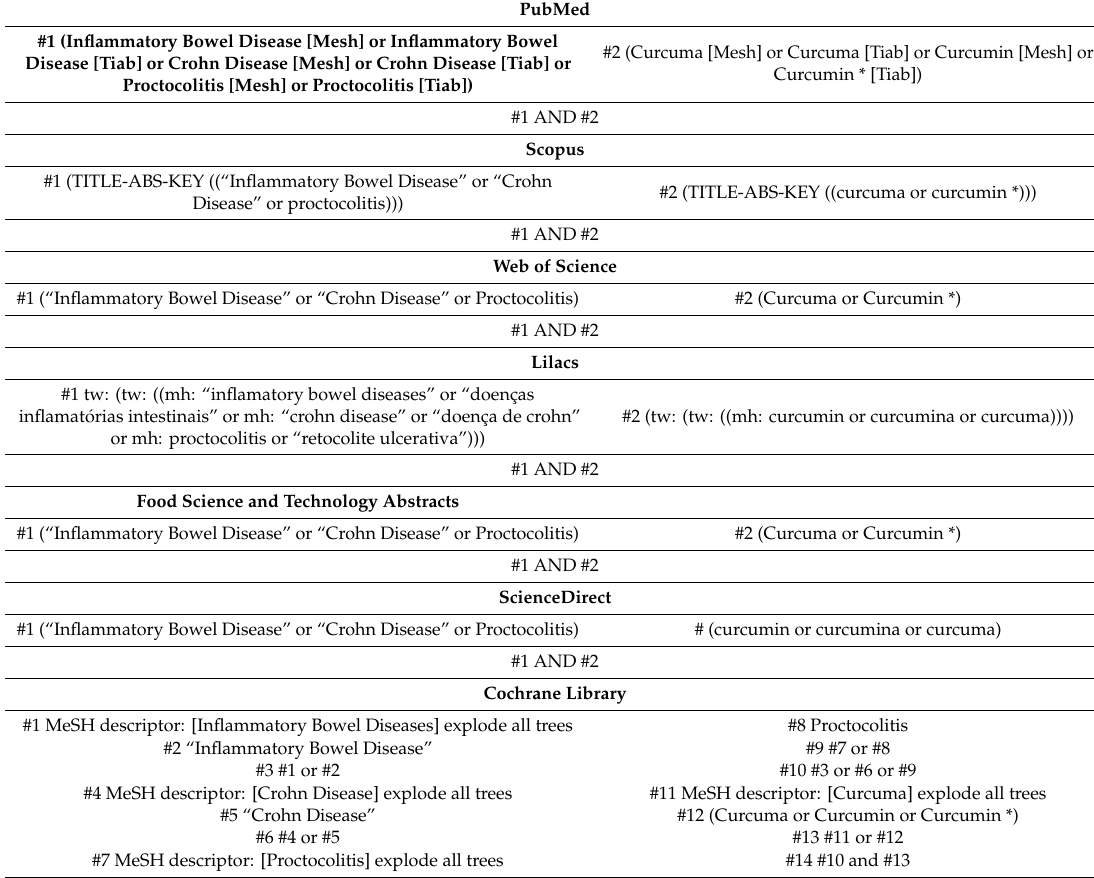
Table 1. Electronic Databases and Respective Search